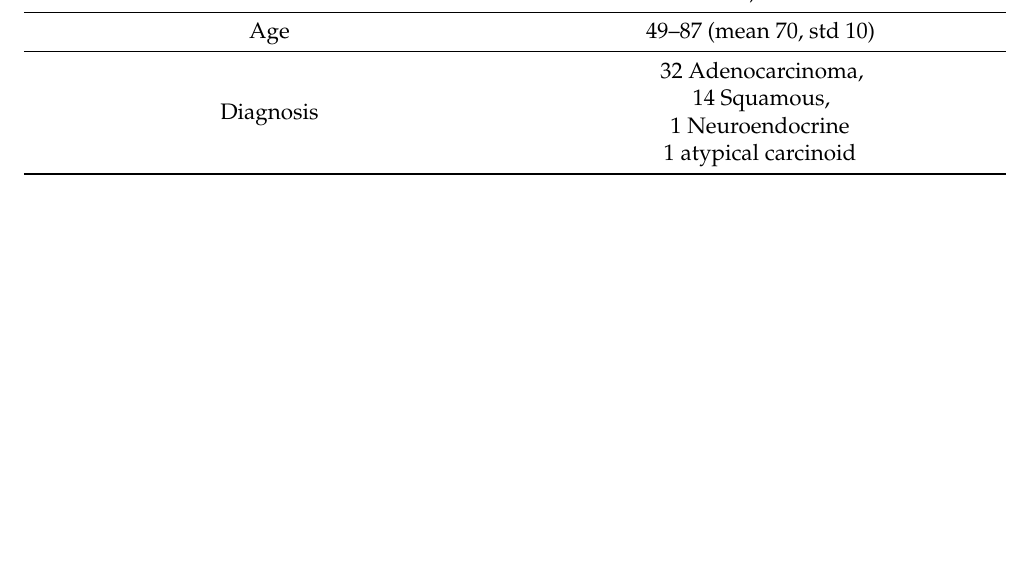
Table 2. Patient characteristics.